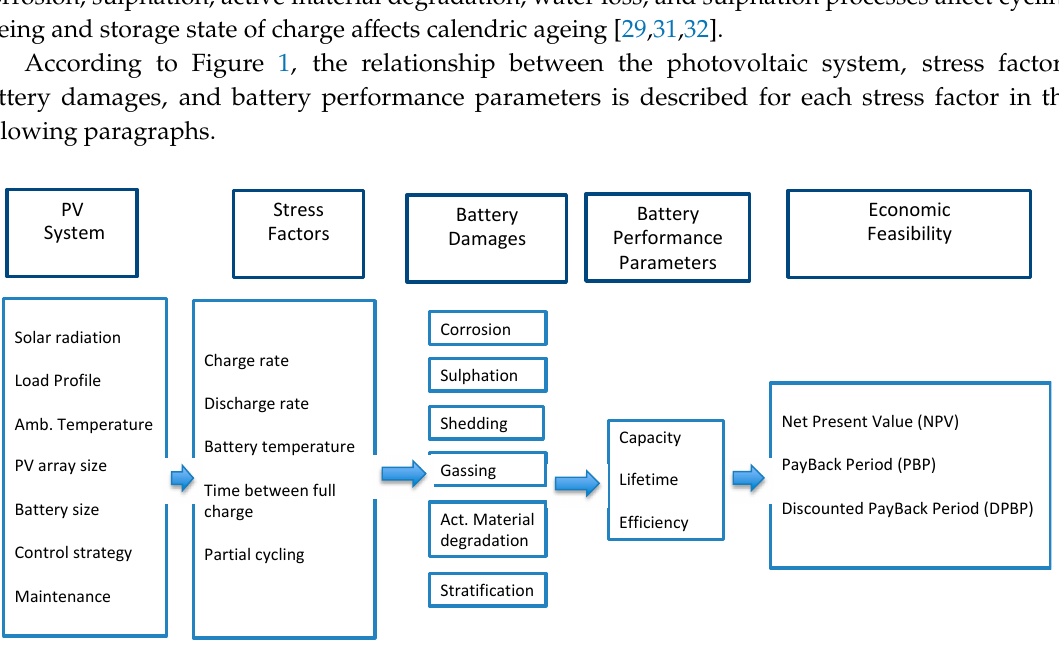
Figure 1. Relationship among photovoltaic (PV) system parameters, battery performance, Net Present Value (NPV), PayBack Period (PBP), and Discounted PayBack Period (DPBP).